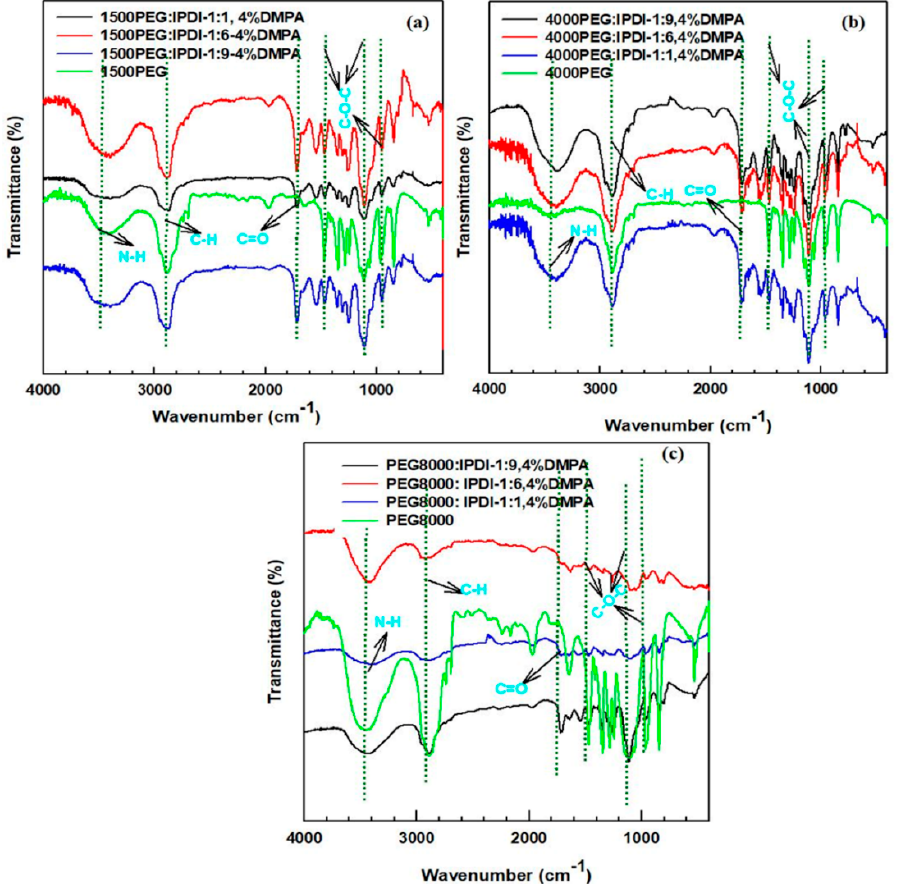
Figure 2. FT-IR results of WSPU: ( a ) 1500 polyethylene glycol (PEG): isophorone diisocyanate (IPDI) with 4% dimethylolpropionic acid (DMPA) and 1500PEG, ( b ) 4000PEG: IPDI with 4% DMPA and 4000PEG, ( c ) 8000PEG:IPDI with 4% DMPA and 8000PEG.